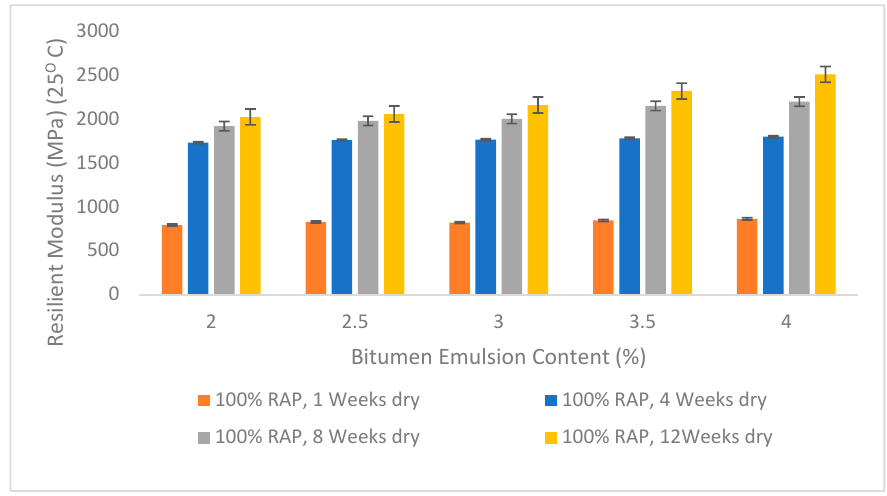
Figure 5. Resilient modulus for 100% RAP in the dry condition after 1, 4, 8, and 12 weeks.